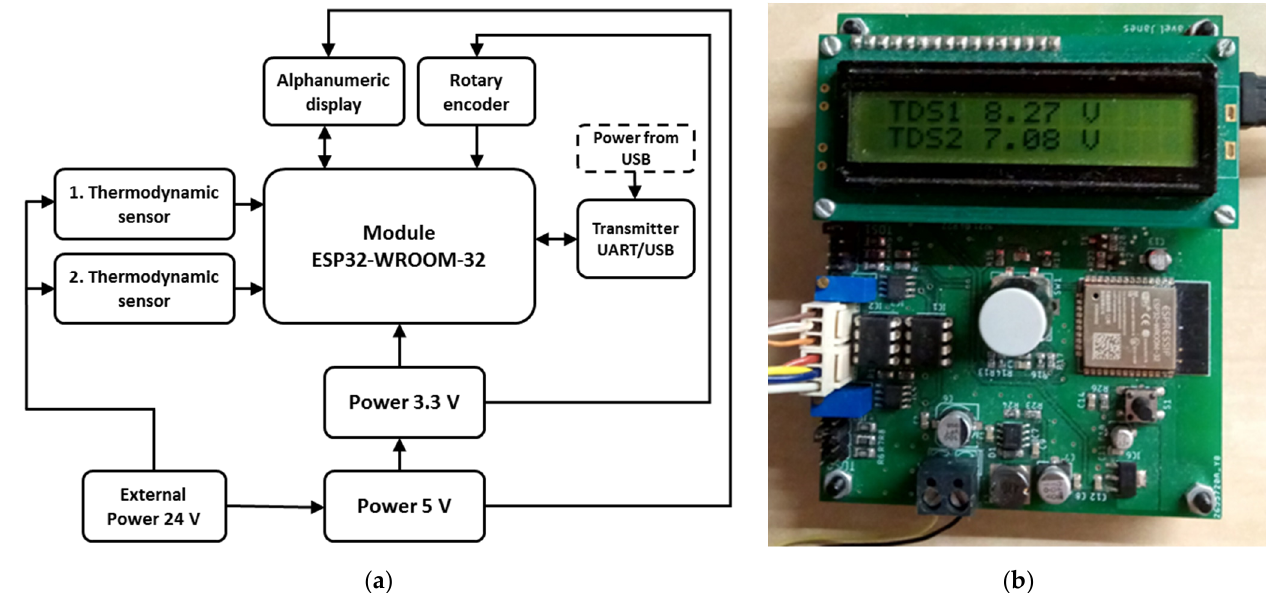
Figure 1. Experimental equipment: ( a ) Block diagram; ( b ) Prototype board of the measuring unit.